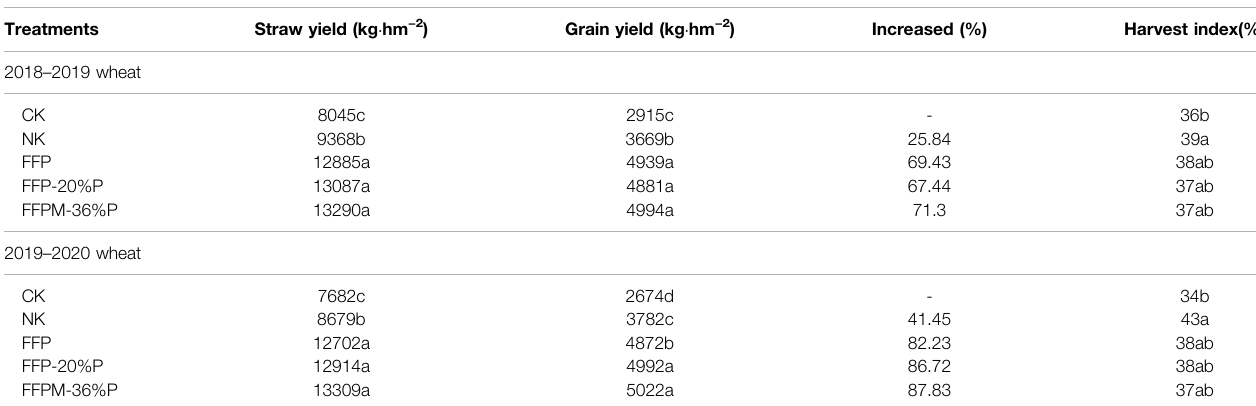
TABLE 6 | Effect of optimized fertilization on wheat yield.